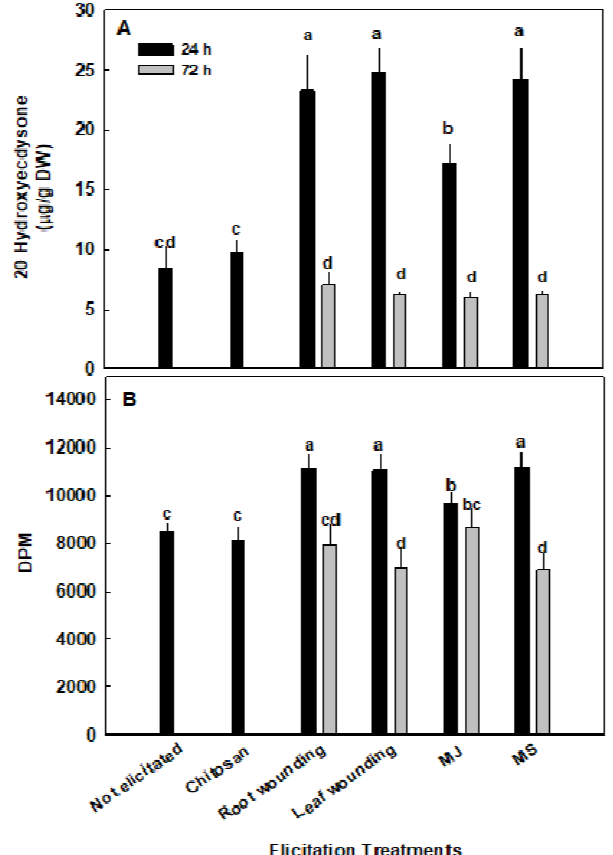
Figure 2. 20HE content and anabolic activity in elicited Turkey variety spinach plant leaves. ( A ) 20HE content was quantified using partially purified extracts of leaves from elicited spinach analyzed via HPLC; ( B ) [3H] Leucine incorporation in L6 myotubes treated with elicited spinach extracts for 4 h was measured. Decays per minute (DPM) was normalized by total protein. The data represent the mean values ± standard error of the mean (SEM) of four replicates. Di ff erent letters above the means represent significant di ff erence based on Tukey’s honestly significant di ff erence (HSD) test at α =